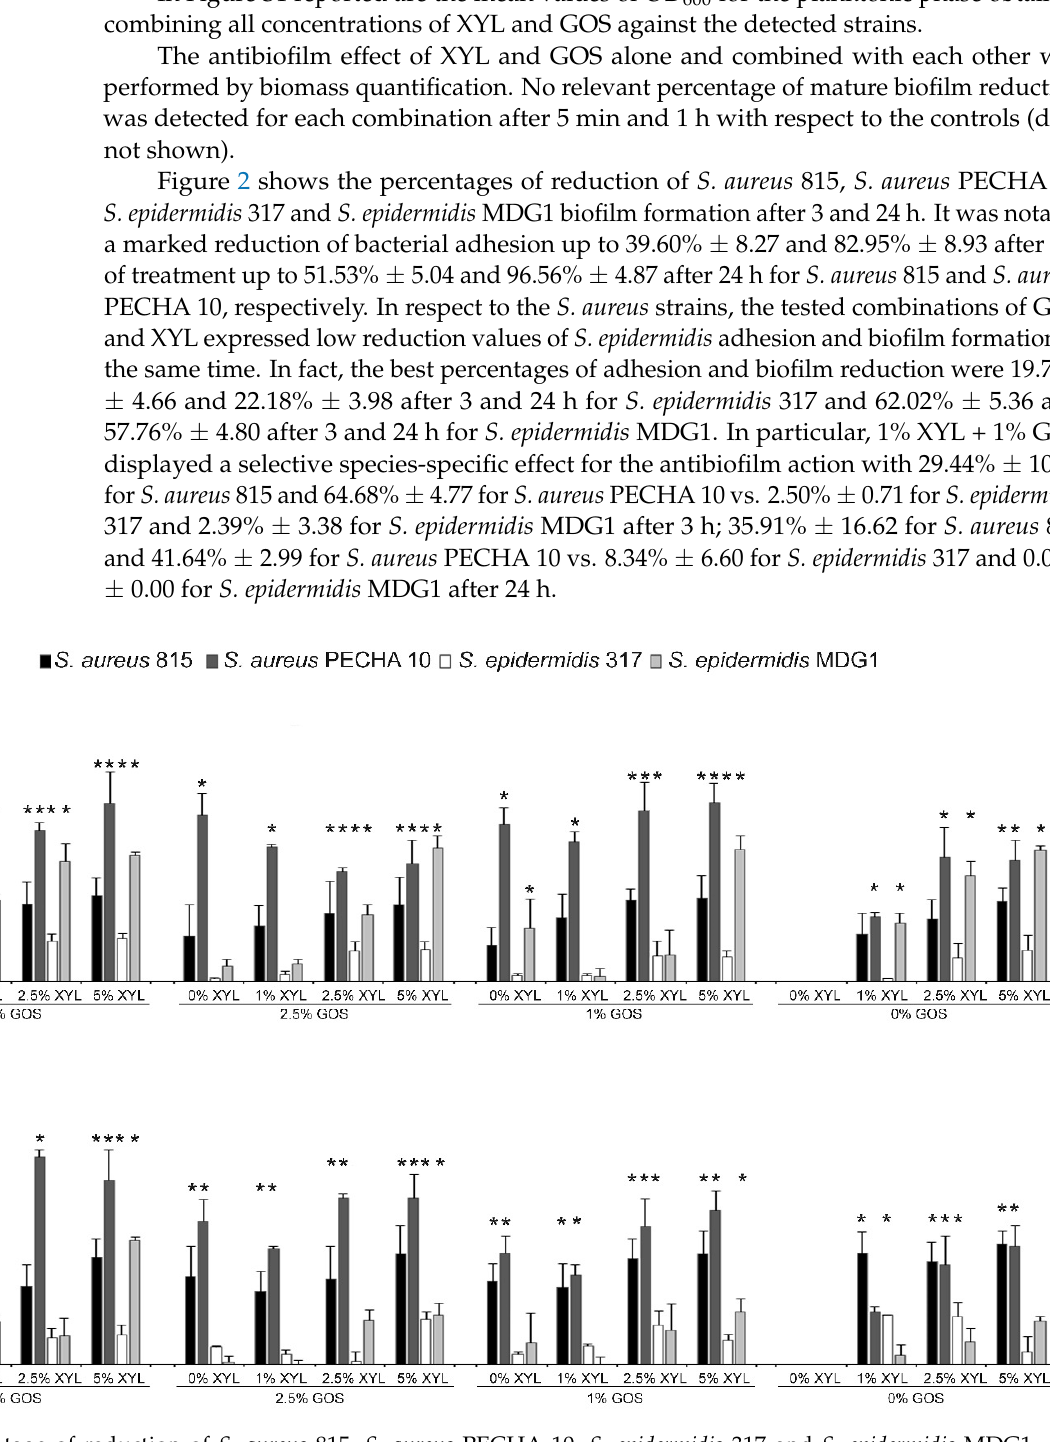
Figure 2. Percentage of reduction of S. aureus 815, S. aureus PECHA 10, S. epidermidis 317 and S. epidermidis MDG1 adhesion at 3 h ( A ) and biofilm formation at 24 h ( B ) after treatment with different combinations of Xylitol (XYL) and Galacto-OligoSaccharide (GOS) at different concentrations. * statistically significant with respect to the control. The mean values of produced biofilm biomasses obtained with the different combina- tions of XYL and GOS for all detected strains are shown in Figure Based on these results, the combination 1% XYL plus 1% GOS was chosen as the ref- erence control (RC) to screen XYL combined with 1% FOS or IMO or LAG or inulin or dextran both for antimicrobial and antibiofilm evaluations.